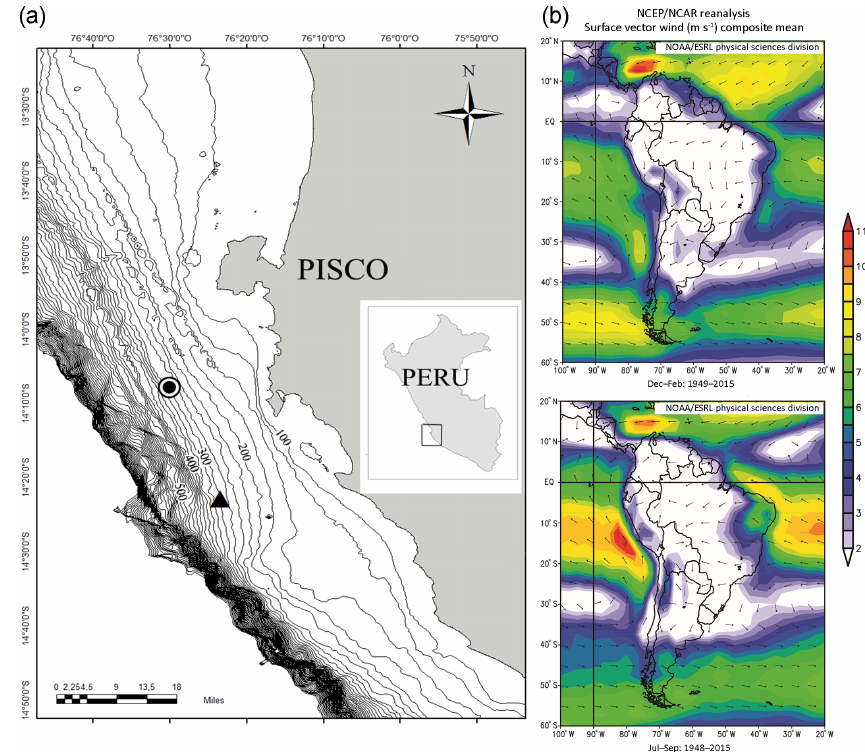
Figure 1. (a) Location of the sampling of the sediment cores B040506 (black circle) and G10-GC-01 (black triangle) in the central Peru continental margin. Bathymetric contour lines are in 25m intervals from 100 to 500m depth. (b) Mean surface vector wind velocity (ms − 1 ) composite mean for summer (up) and winter (down) between 1948 and 2015 for South America. NCEP/NCAR Reanalysis